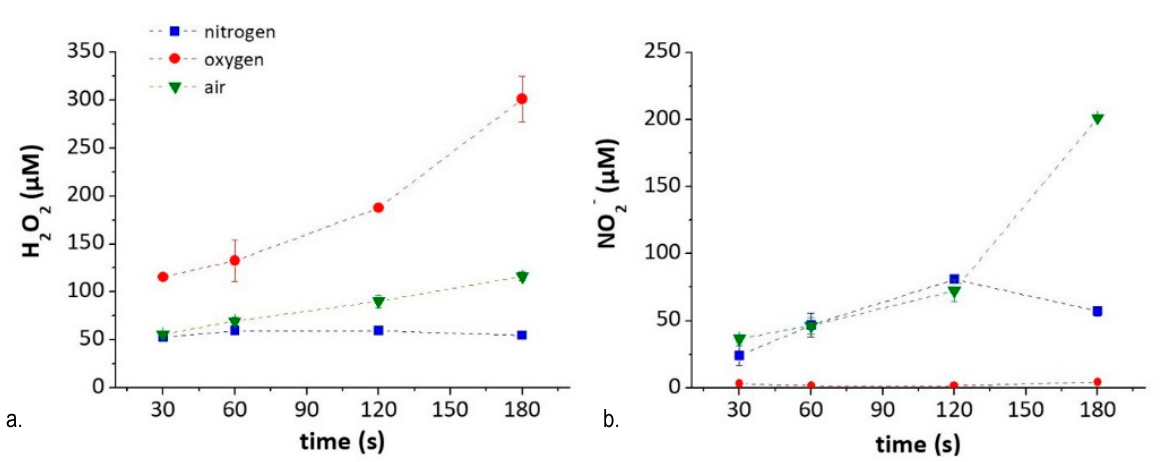
Figure 7. Chemical composition of PTWS as a function of experimental conditions- Content of ( a ) H 2 O 2 and ( b ) NO 2 − in PT-DMEM according to feed composition and treatment time.